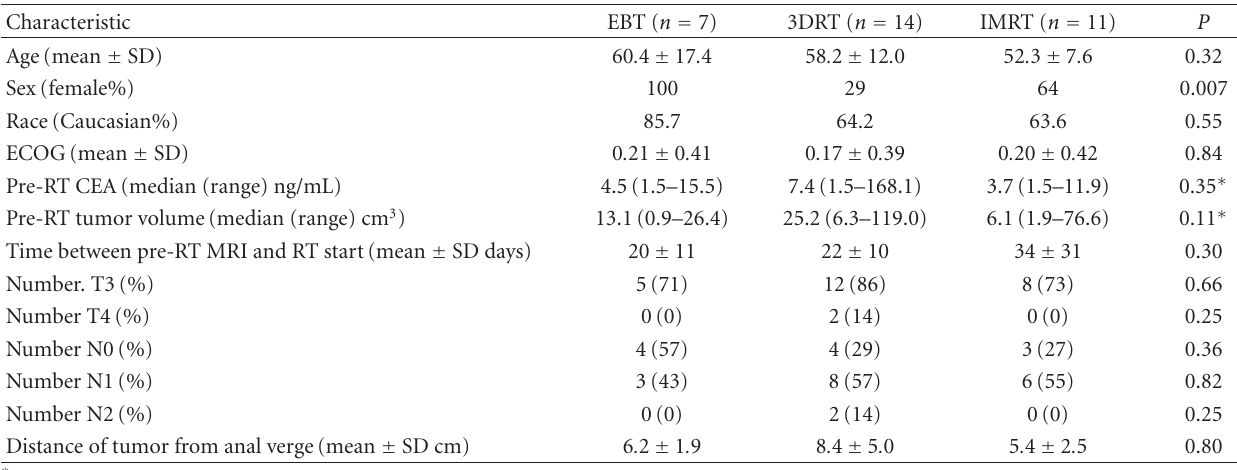
Table 1: Demographic and baseline disease characteristics for patients broken down by EBT, 3DRT, and IMRT groups with statistical comparison. EBT: endorectal brachytherapy; 3DRT: 3D conformal radiotherapy; IMRT: intensity-modulated radiotherapy; ECOG: eastern cooperative oncology group performance status; RT: radiotherapy; CEA: carcinoembryonic antigen.